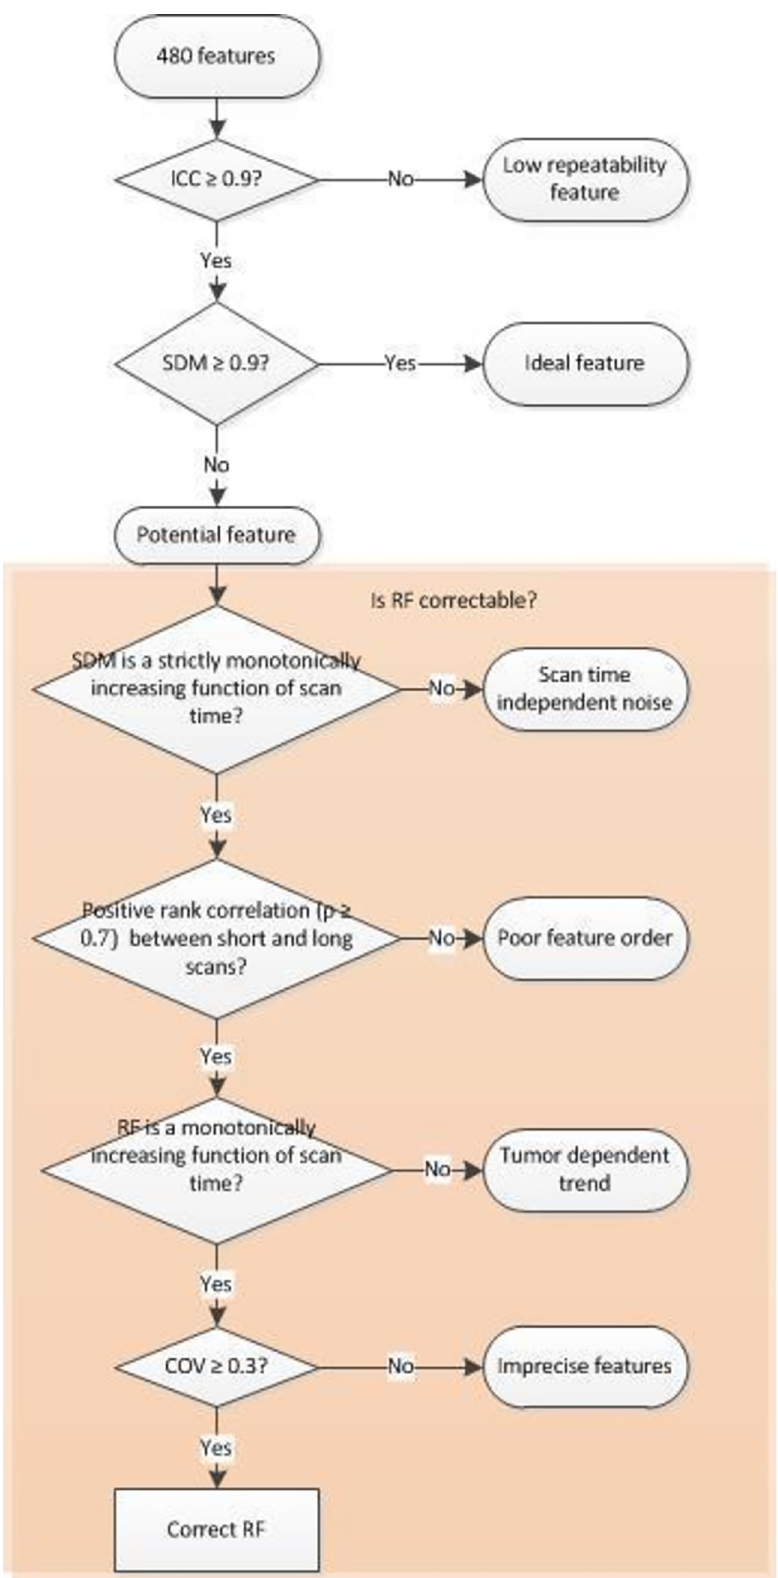
Fig 2. The tests performed to check feature